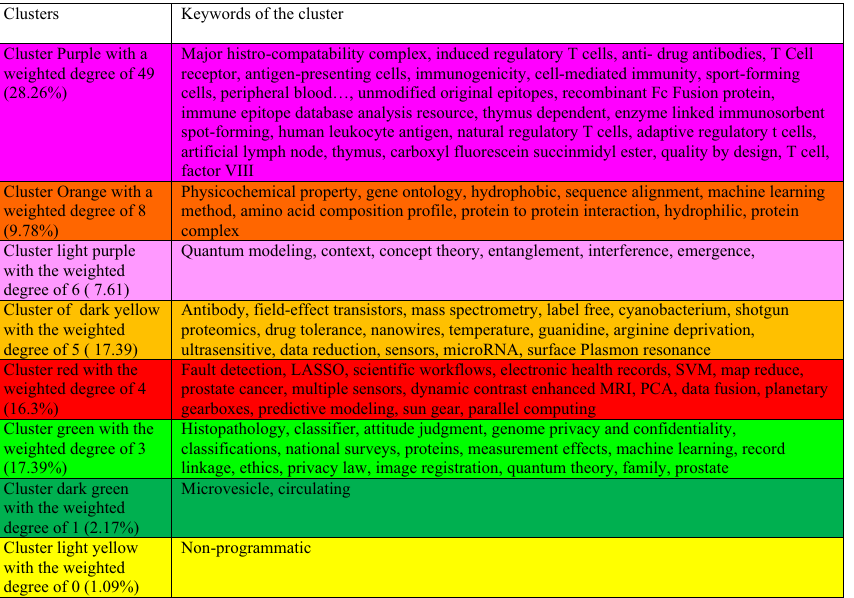
Table 3 Clusters of the co-occurrence of keywords of scientific works cited by the patents Clusters Keywords of the